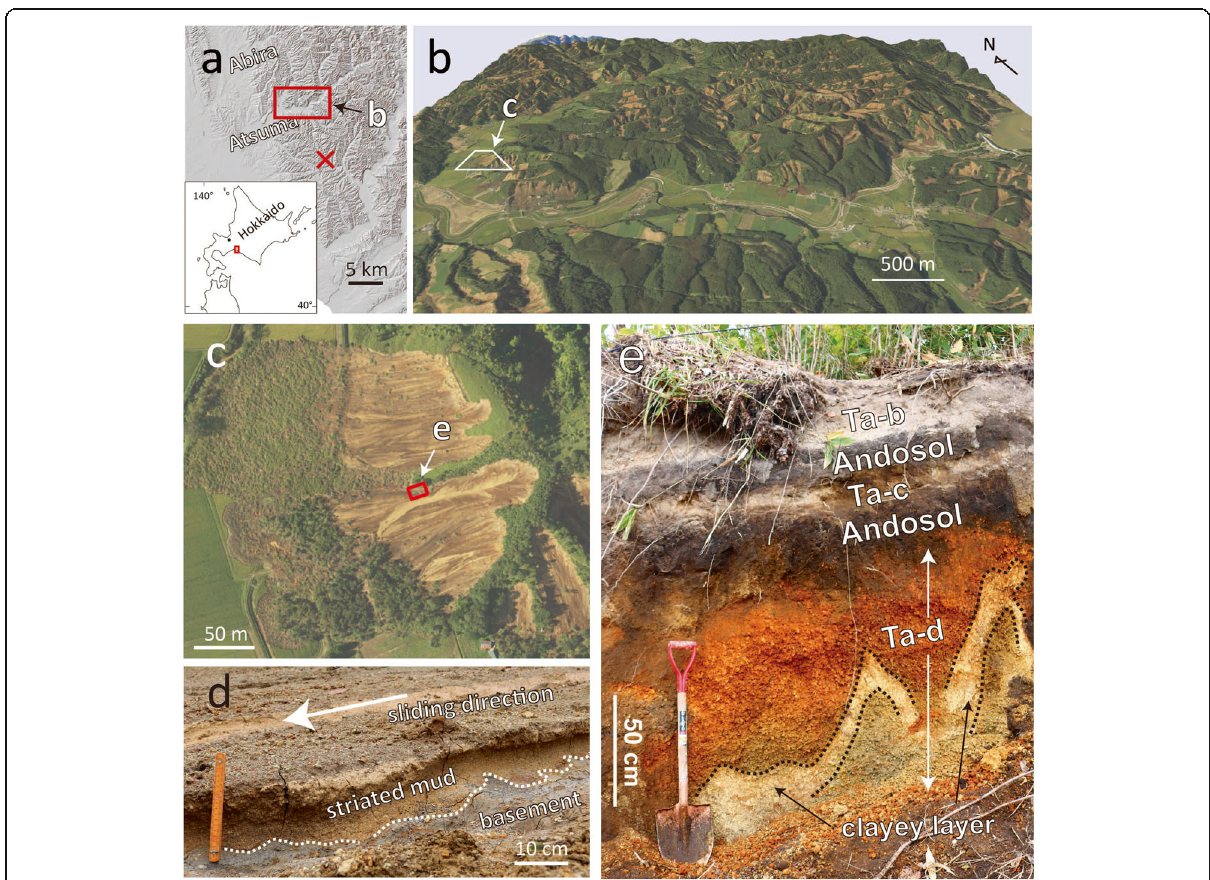
Fig. 1 Location and occurrence of the studied landslide. (a) Locations of the epicenter of the Eastern Iburi earthquake (red cross) and the study area. (b) 3D view of the hills near Atsuma after the earthquake (produced by data from the Geospatial Information Authority of Japan 2018a). (c) Close-up photograph of the studied landslide (taken on 6 September 2018; Geospatial Information Authority of Japan 2018b). (d) Striated mud on the collapsed slope (modified after Kameda et al. 2019). (e) Scarp measuring 2 – 3 m in height, which contains a stratigraphic sequence of volcanoclastic deposits (modified after Kameda et al. 2019). The slip surface material analyzed in this study was collected where the “ clay layer ” is in contact with the basement Neogene marine